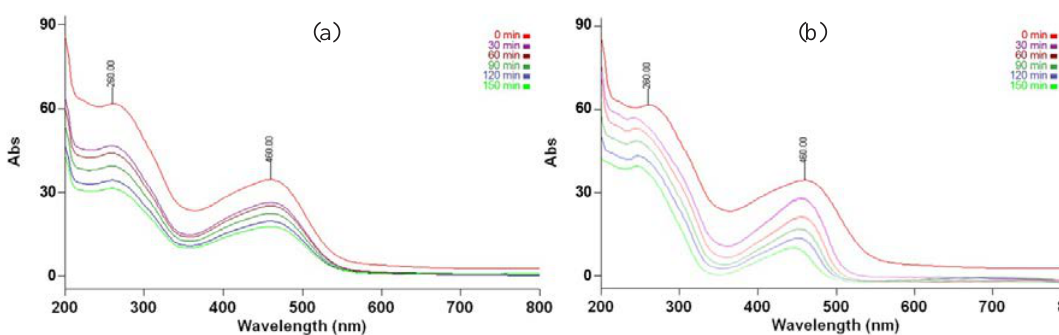
Fig. 10. Photocatalytic activity of nanocomposite (a) Ce-TiO2/bentonite (b) Nd-TiO2/ bentonite Table 5. Removal %RSD lead (II) and cadmium (II) ion by Nd-TiO2/ bentonite and Ce-TiO2/bentonite nanocomposites in the pres- ence and absence of light